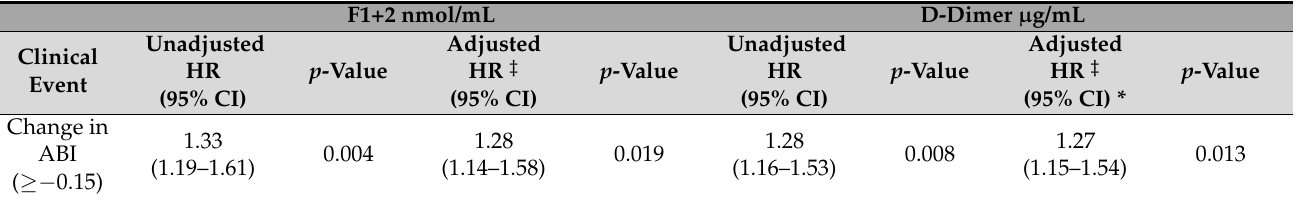
Table 2. Univariate and multivariate Cox proportional hazard analysis of clinical events for F1+2 (nmol/mL) and D-dimer ( µ g/mL) at two-year follow-up. F1+2 nmol/mL D-Dimer µ